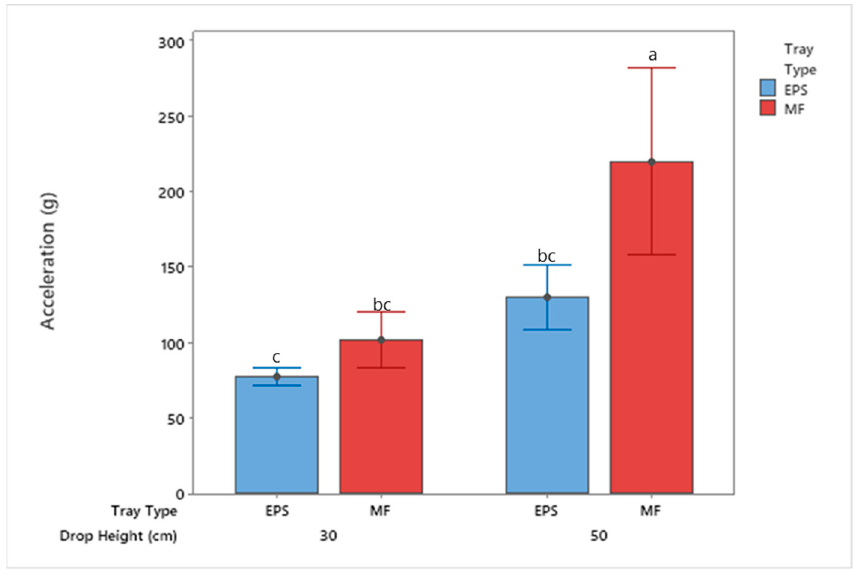
Figure 10. Impact acceleration from the free-fall drop events of apples by tray location packaged using MF and EPS trays from 30 and 50 cm drop height (mean ± SD, n = 2). Different letters indicate statistically significant differences at p < 0.05. Bars with no common letters are significantly different ( p < 0.05).